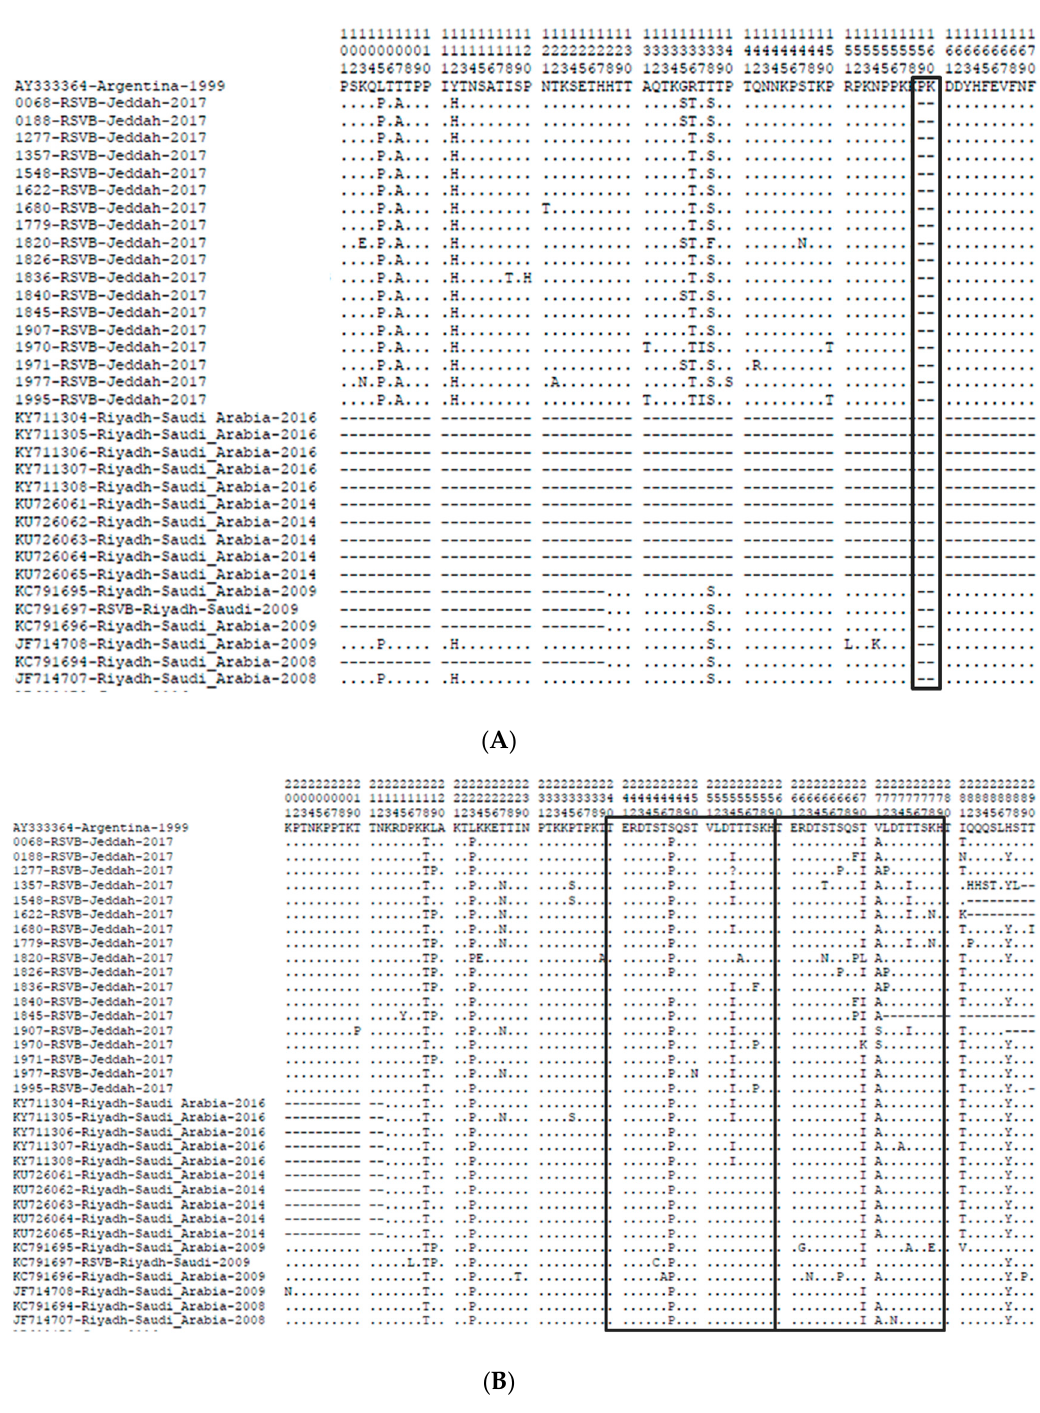
Figure 5. The sequences alignment of deduced amino acid. ( A ) The deletion part in our samples. ( B ) The deduced amino acid in the second hypervariable region of the G protein of the RSV-B group for the BA strain shown to correspond to the BA prototype strain from Argentina (GenBank accession number AY333364). The positions of amino acids correspond to 213–320 of the G protein. Dots are indicated for identical residues, and asterisks indicate the position of stop codons. Boxes frame the 20 amino acid duplicated